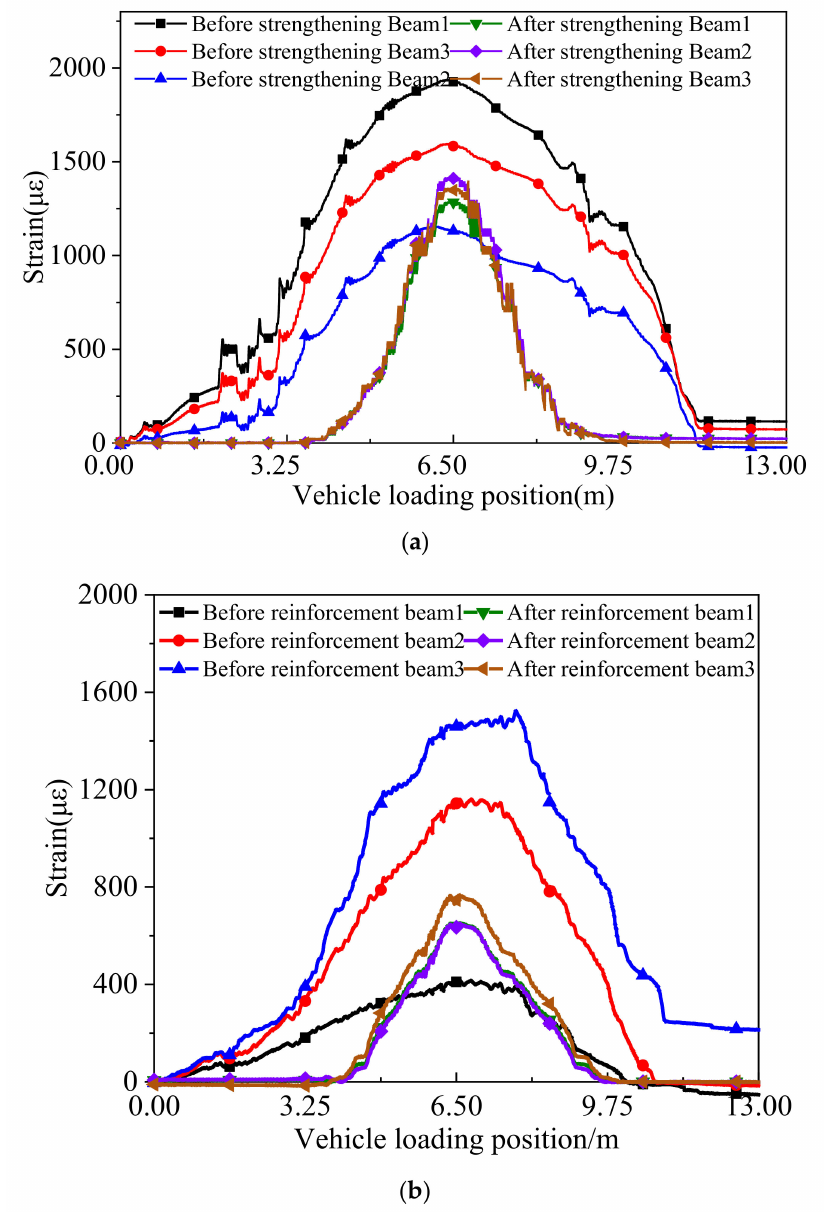
Figure 12. Concrete strain curves of the box girder at the mid-span under continuous